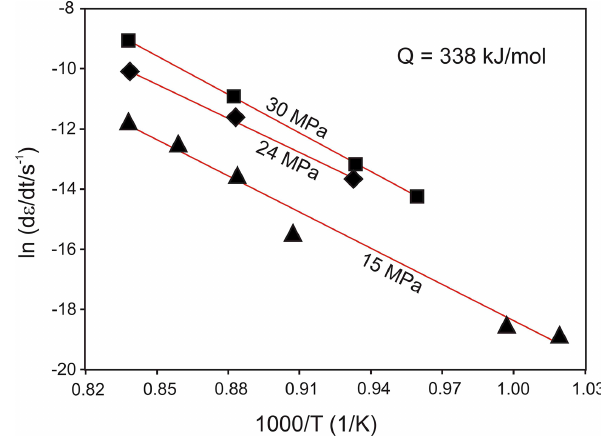
Figure 6. Derivation of stress exponent n in a log–log plot of refer- ence strain rate ˙ ε versus reference flow stress σ at various constant temperatures. A mean stress exponent of n = 3 . 9 was derived from creep data obtained at temperatures of 800, 860, and 920, ◦ C.